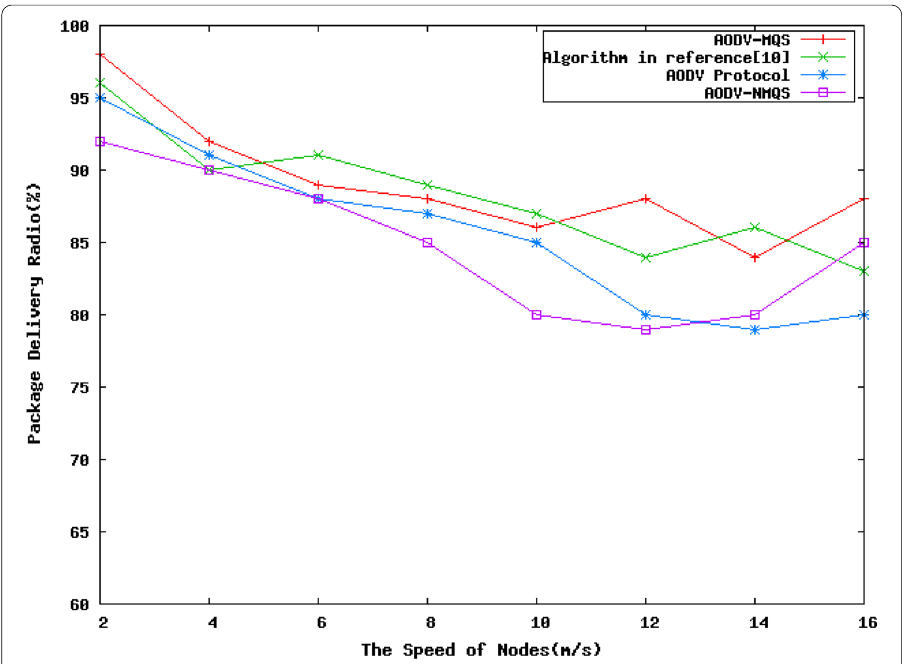
Fig. 8 Comparison of delivery radio of four routing algorithms in a safe